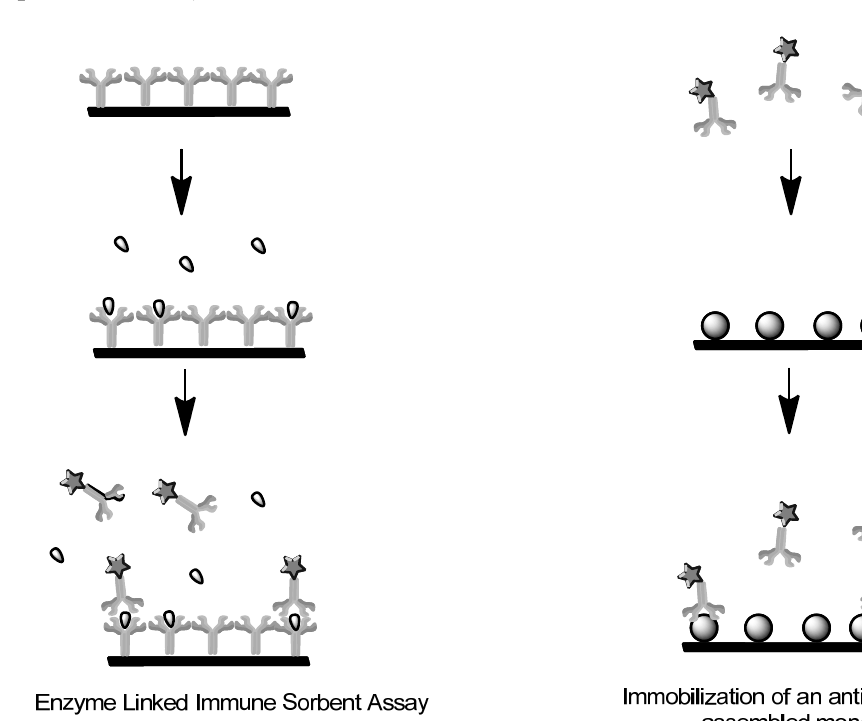
Figure 4. Amperometric immunosensor based on a new electrochemical detection scheme (adapted from